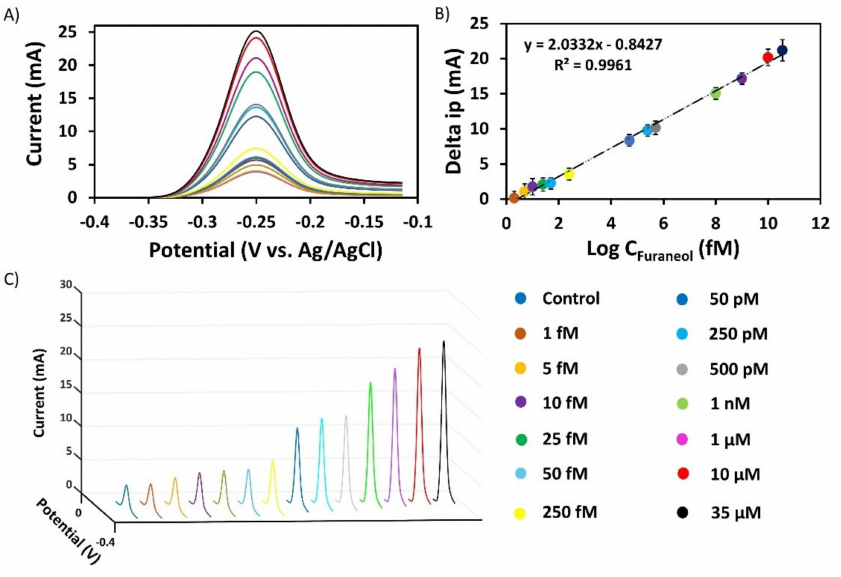
Figure 5. ( A ) and ( C ) Variation of the aptasensor response against the furaneol concentrations in the range of 1 fM–35 µ M; ( B ) The linear relationship between the peak currents and furaneol concentration ranging from 1 fM to 35 µ M (n = 5).